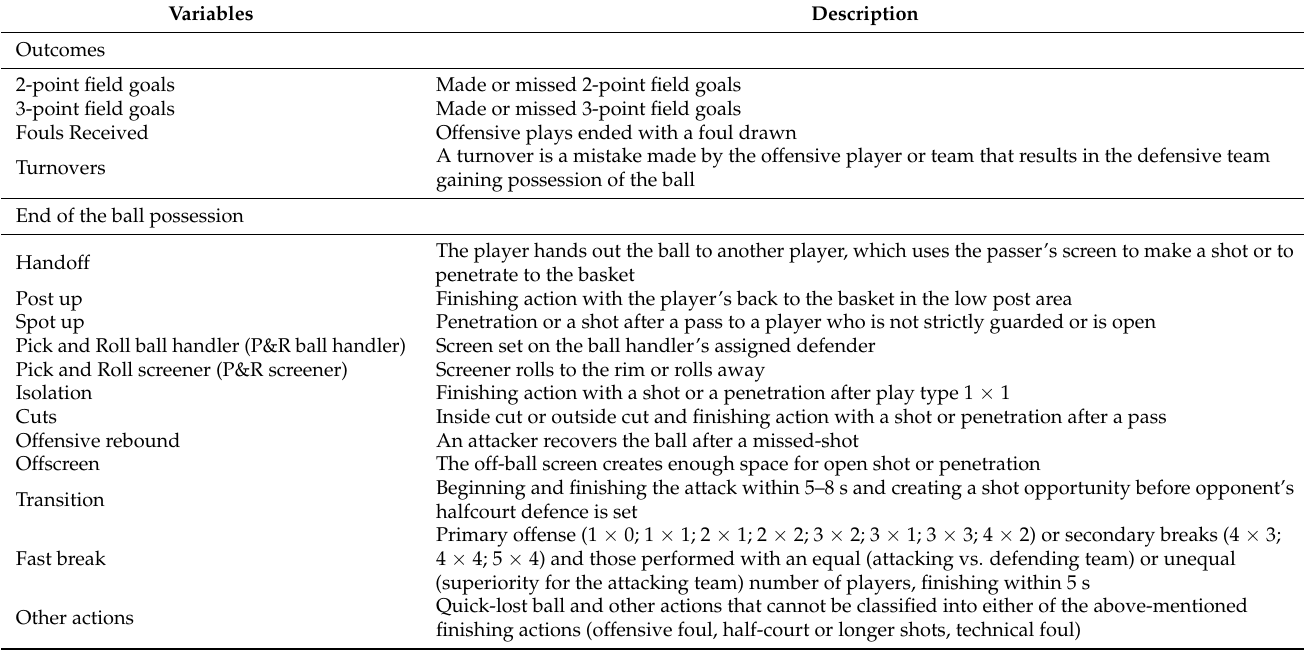
Table 1. Definition of outcomes and ends of the ball possession play